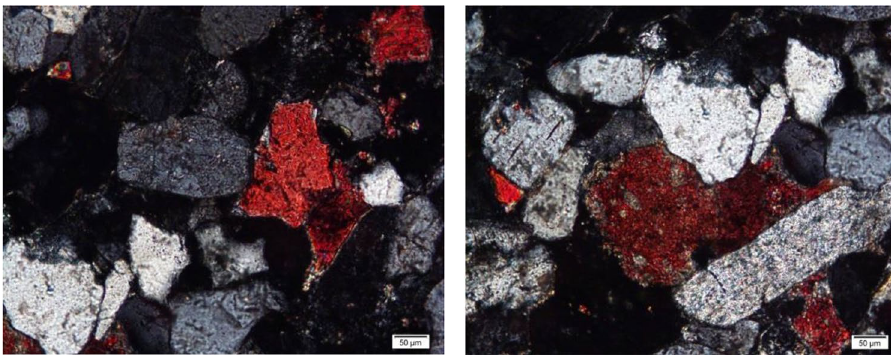
Fig. 8 The carbonate cementa- tion in Well